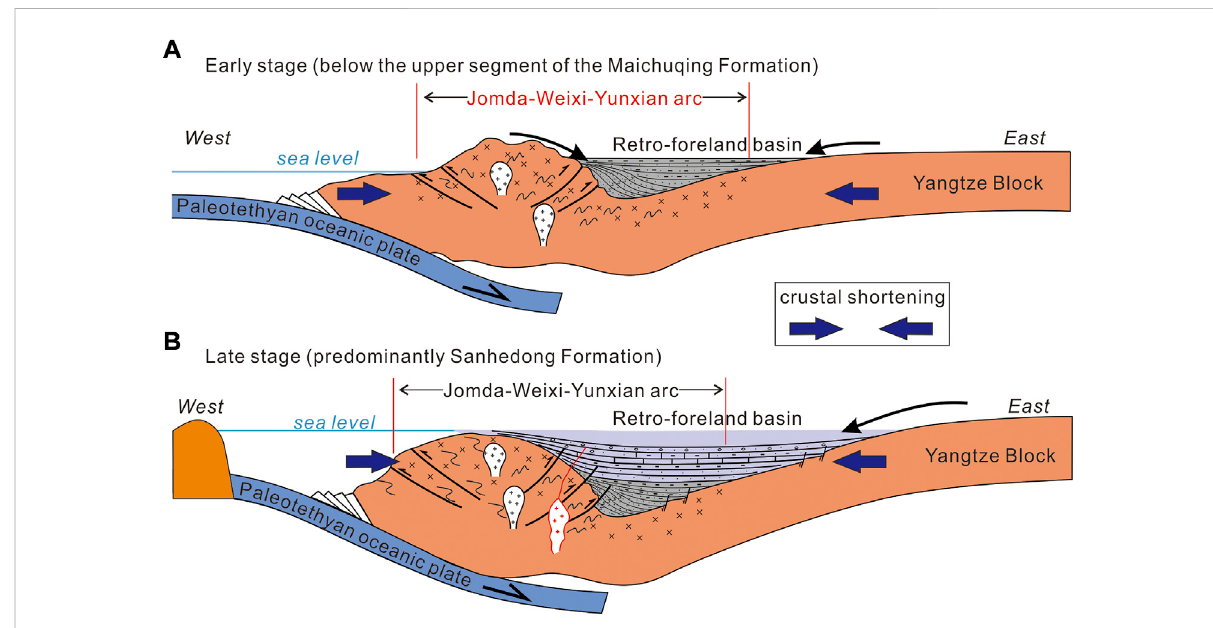
Cartoons show the development of the early Late Triassic retro-foreland basin, SE Tibet. See text for detail